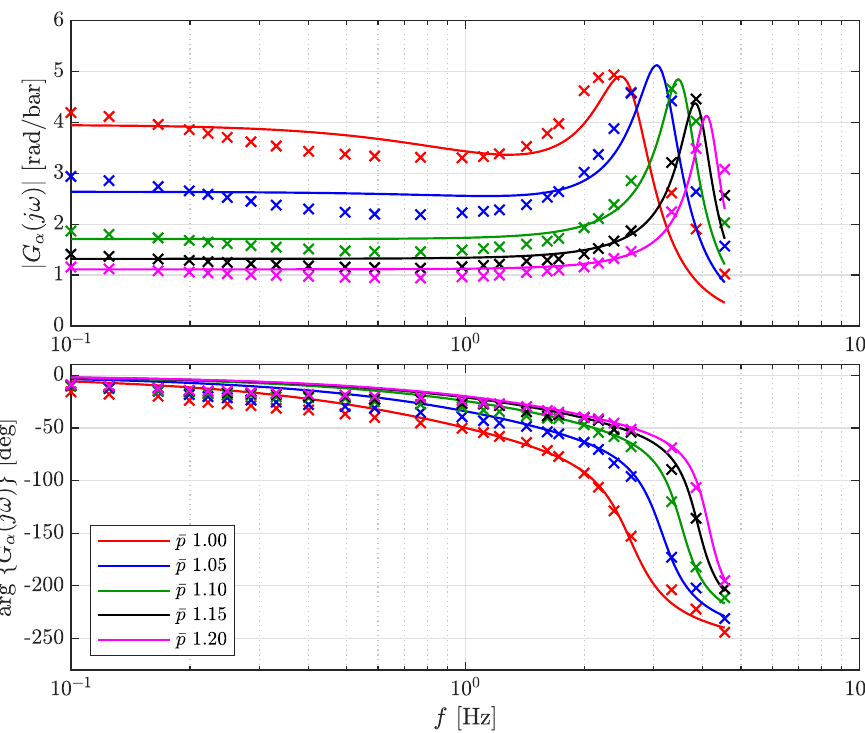
Figure 10. The frequency response in the α -direction for different lower pressure levels ¯ p with the magnitude in the top plot and the phase in the bottom plot. The measured frequency responses resulting from the identification experiments are indicated by the crosses and the corresponding fits by the solid lines. For increasing values of ¯ p , the magnitude of the frequency response decreases and the resonance frequency of the system increases. The error between measured and fitted frequency response could be further reduced for small values of ¯ p by adding an additional zero to the fitted transfer function. However, we reject the extension for the sake of simplicity and in order to have a constant model structure for all values of ¯ p